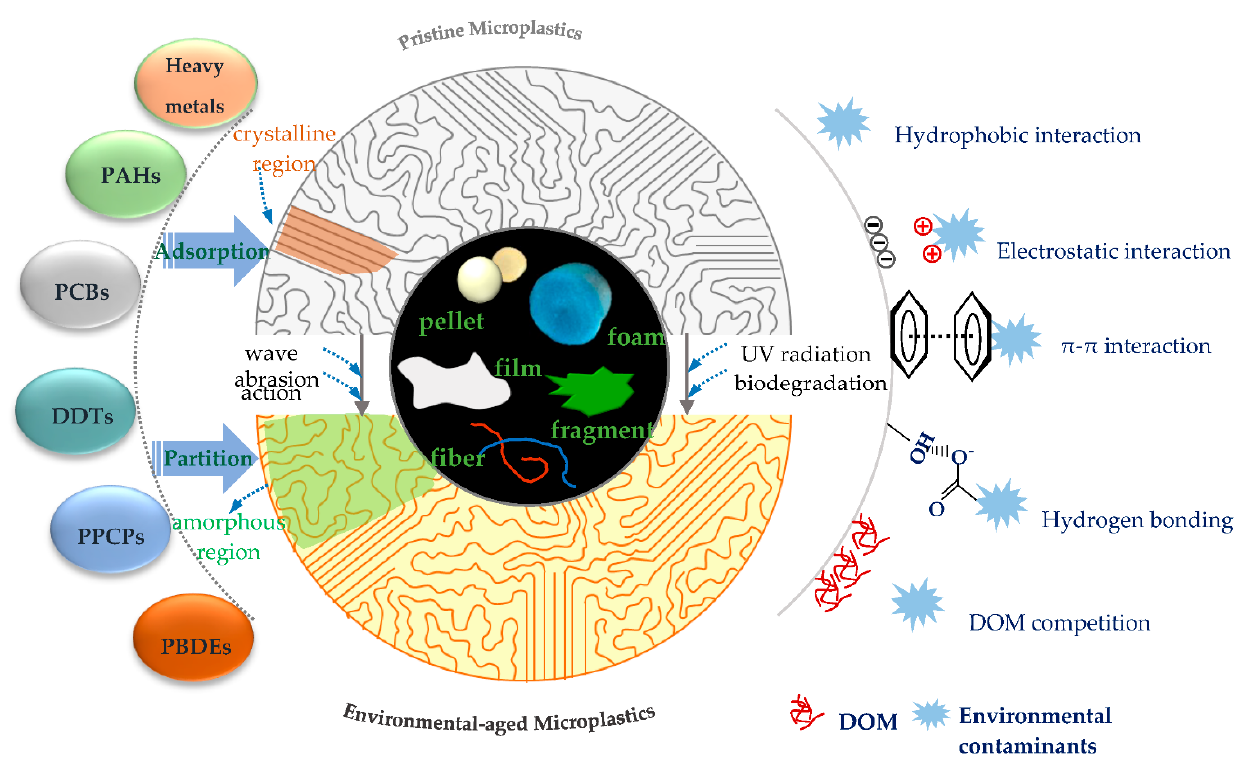
Figure 3. Schematic description of the interaction and mechanisms between environmental contaminants with micro-plastics.